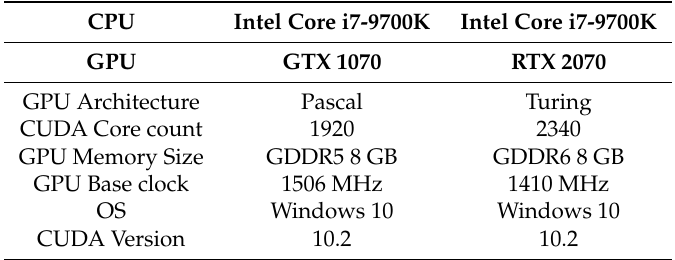
Table 9. GPU optimization implementation test